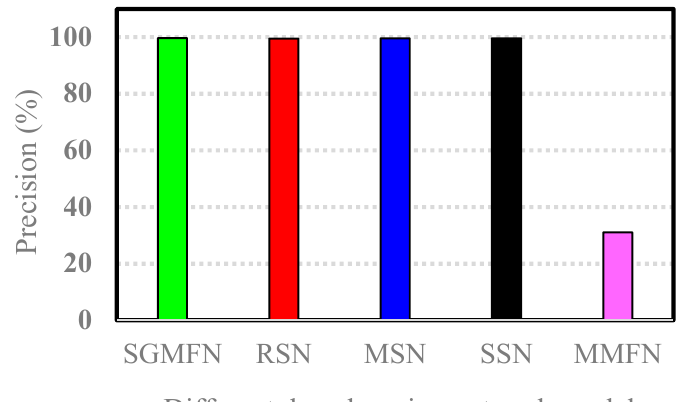
Figure 9. Comparison results of precision of different network models.